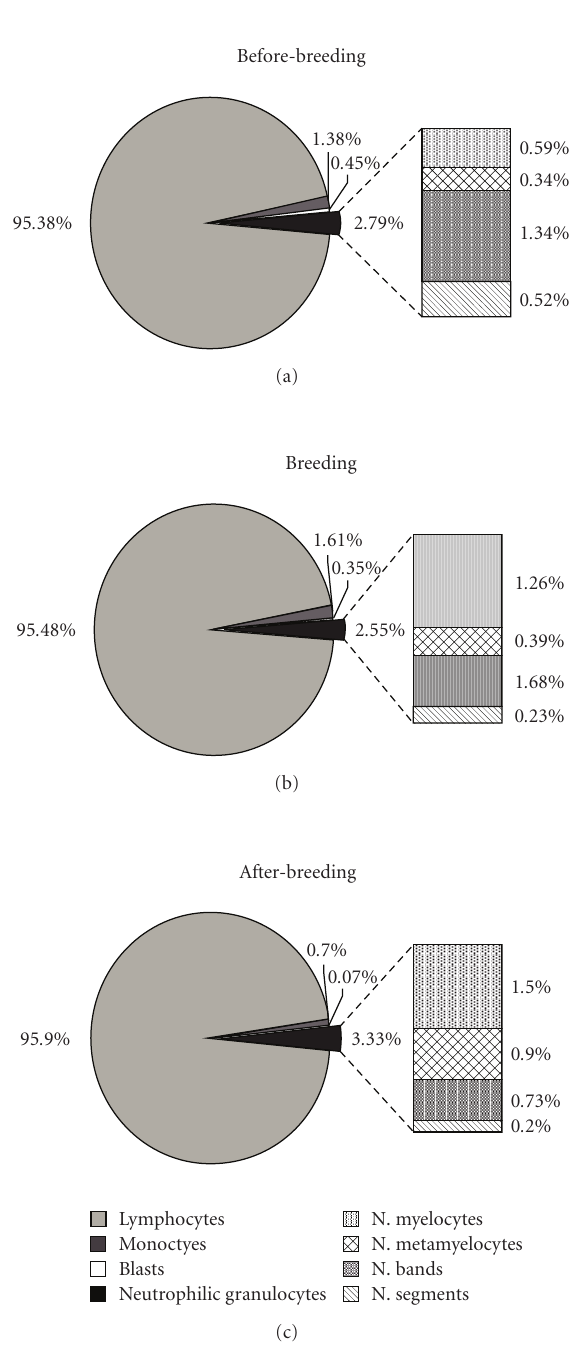
Figure 1: Changes in leukocyte di ff erential count in three periods